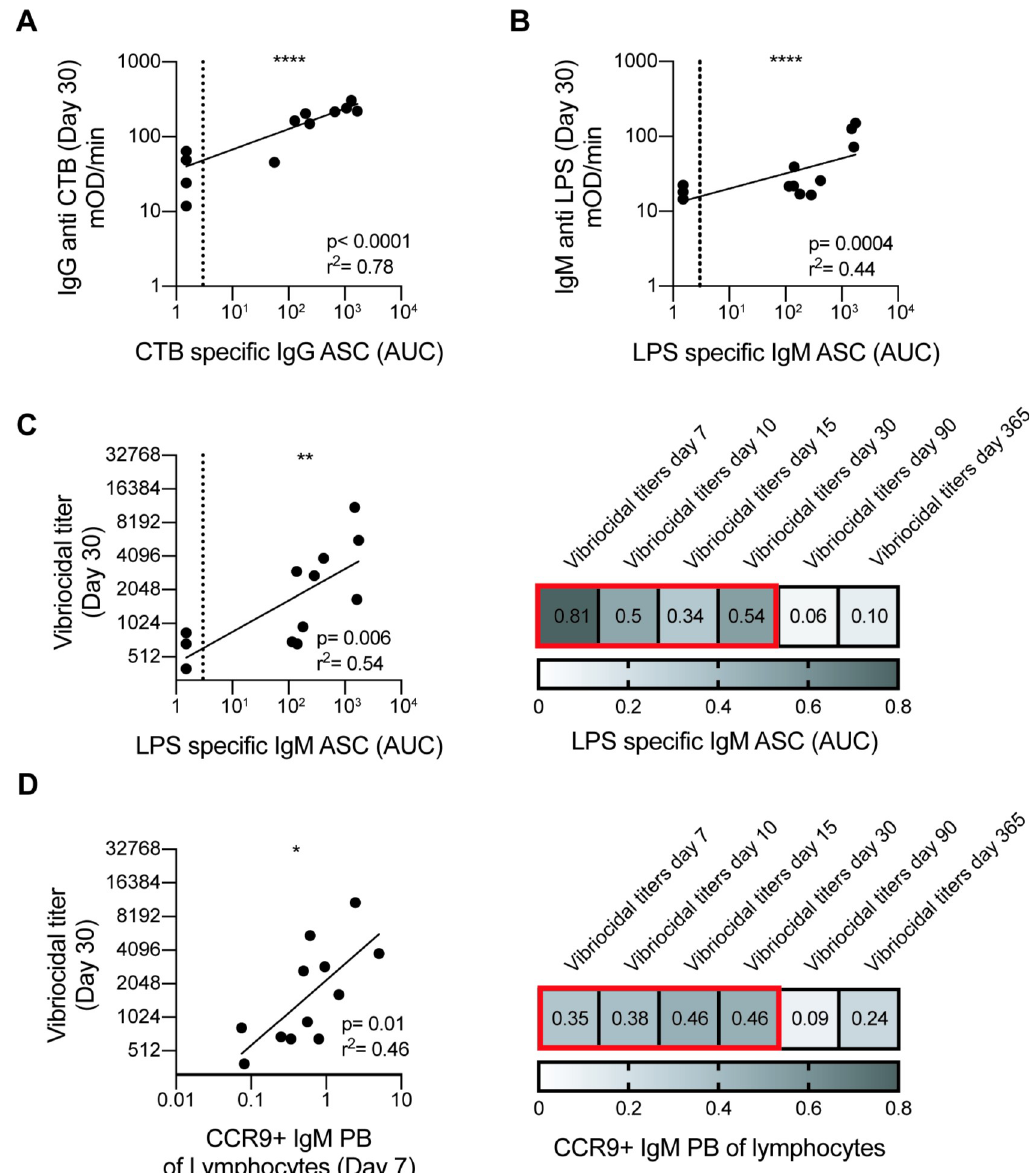
Fig 4. Correlations between early and late humoral responses. Linear regression analysis between (A) cholera toxin B subunit (CTB) specific IgG ASC and IgG CTB plasma titers at day 30 post vaccination. (B) Linear regression analysis between lipopolysaccharide (LPS) specific IgM ASC and IgM LPS plasma titers on day 30 post vaccination. (C) Representative (left panel) and summary (right panel) of linear regression analysis between LPS specific IgM ASC and vibriocidal plasma titers on day 30. Number in box is the r 2 value and red outline indicates p < 0.05. (D) Representative (left panel) and summary (right panel) linear regression analysis between CCR9+ IgM plasmablast of total lymphocytes and vibriocidal plasma titers. Number in box is the r 2 value and red outline indicates p < 0.05. ASC response for (C) and (D) is depicted as area under the curve (AUC) covering days 0, 7, 10, 15, and 30. Correlation analysis performed by log transformation of plasma titers and AUC followed by linear regression analysis. Dotted line represents the limit of detection for ELISPOT